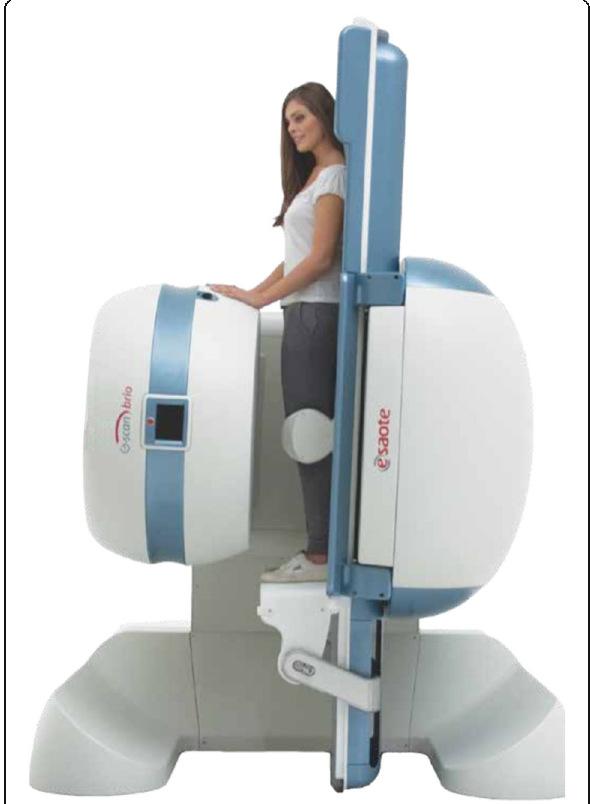
Fig. 2 Scanning position in weight-bearing condition in a low-field MRI-scanner. Adapted with permission from Esaote